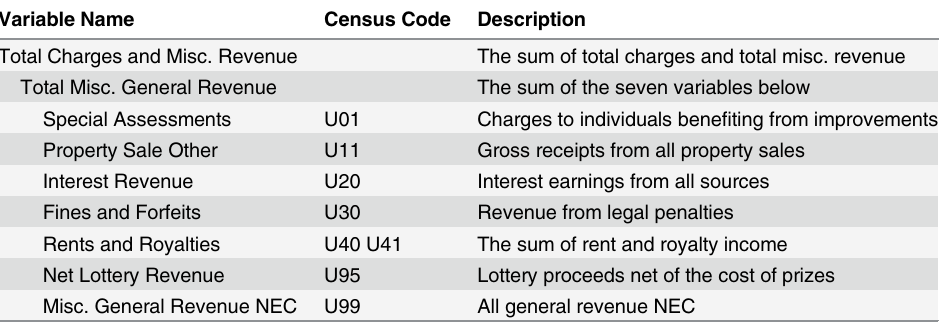
Table 5. Miscellaneous General Revenue